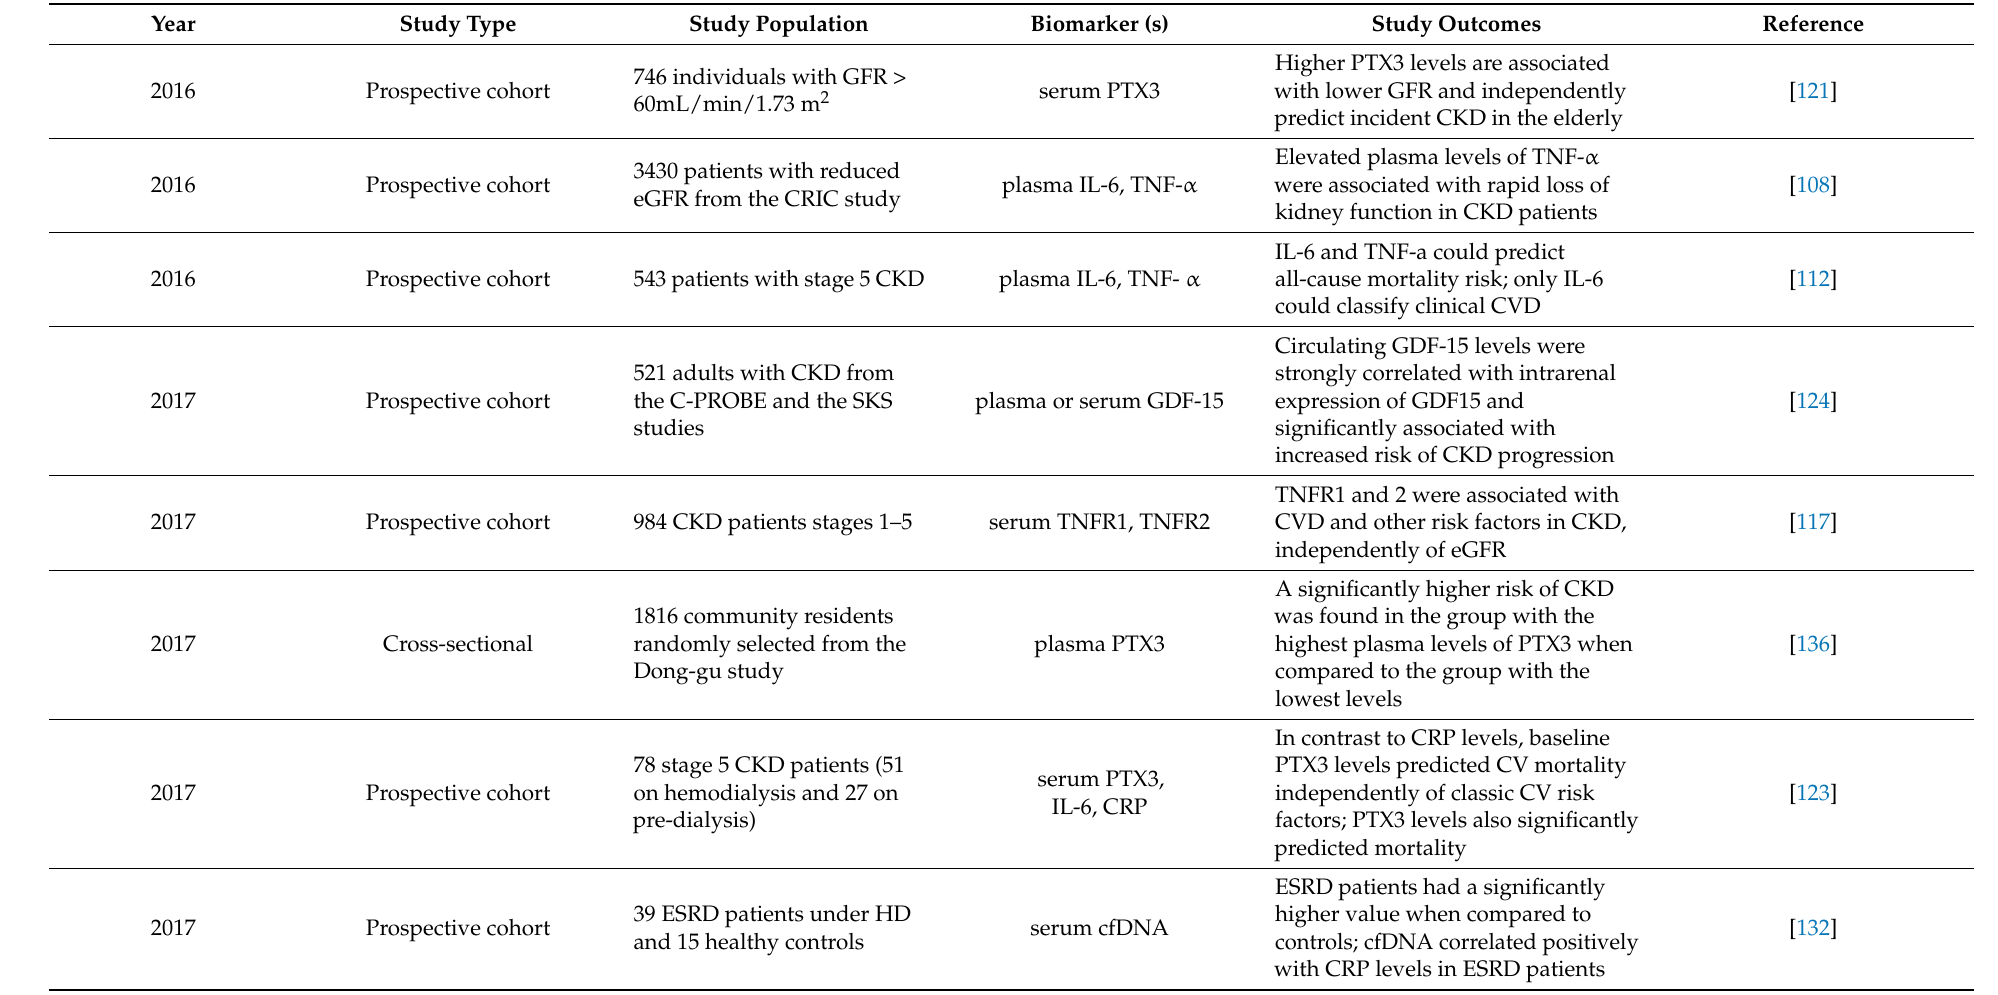
Table 4. Research studies on biomarkers of inflammation and main outcomes in CKD